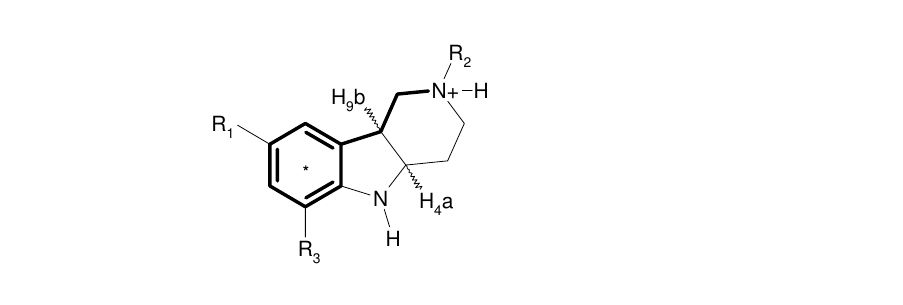
Fig. 2 Numbering scheme of the derivatives studied. Asterisk (*) denotes the middle of the aromatic